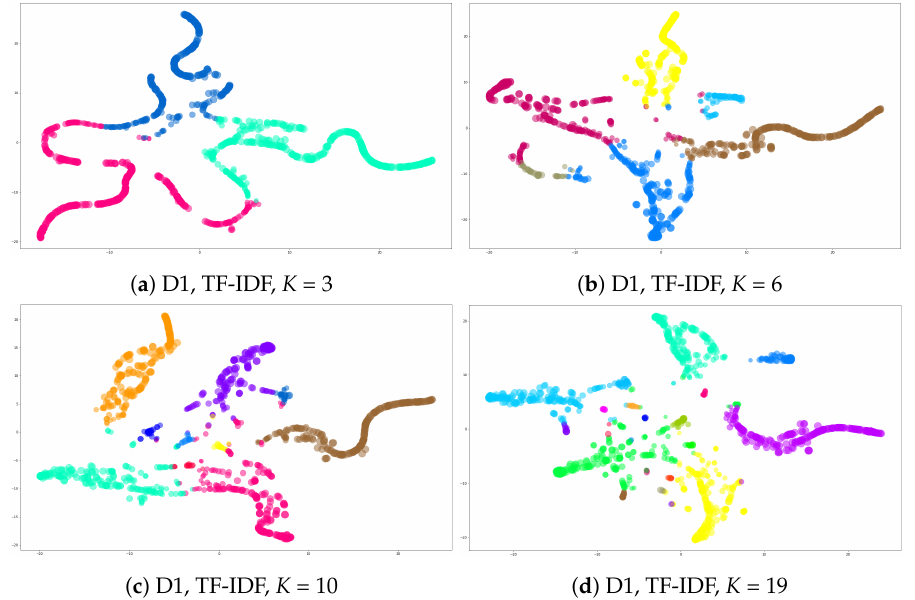
Figure 10. D1 t-SNE representation, TF-IDF weighting scheme, K = 3, 6, 10, and 19,